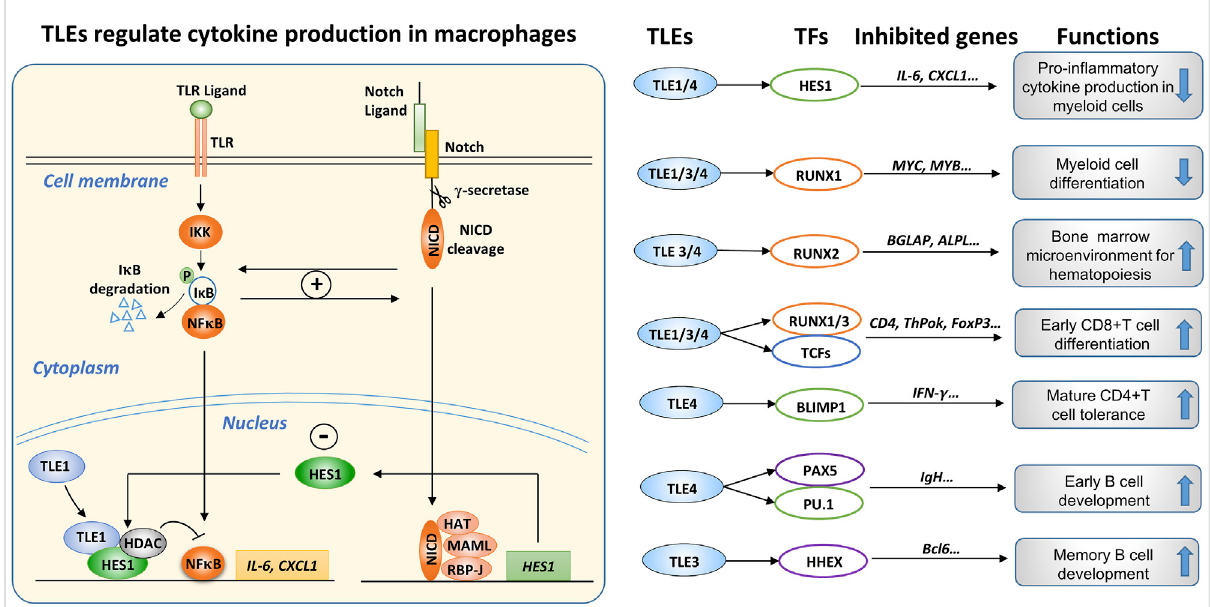
FIGURE 8 The roles ofTLEs in immune regulation. (Left): TLEs are involved inthe interconnection between theTLR and Notch pathwaysin macrophages. The engagement of TLR ligands activates IKK α / β kinase, inducing the phosphorylation and subsequent degradation of I κ B, which sequesters NF- κ B transcription factors (TFs) in the cytoplasm. Consequently, the released NF- κ B TFs, mainly p65 and p50, are translocated from the cytoplasm to the nucleus,wheretheystimulatetheexpressionofproin fl ammatorycytokines,suchasIL-6andCXCL1.Notchactivationinducestheexpressionof target genes, including HES1. The TLR and Notch pathways can regulate each other through a positive feedback loop; however, Notch activation induces the expression of HES1, which can form a transcriptional suppressive complex with TLE1/4 and HDACs, attenuating the expression of in fl ammatory cytokines. Therefore, TLE1/4, and possibly other TLE family members, are involved in the intricate interconnection between the TLR and Notch pathways in macrophages. (Right): Summary of the roles of TLEs in immune regulation, depicting TLE members, interacting TFs, suppressedtargetgenes,andeffects,includingcytokineproductioninmyeloidcells(Ramasamyetal.,2016),myeloidlineagedifferentiation(Simeoni andSomervaille,2021),hematopoiesis(Wheat etal.,2014),earlyTcell differentiation(Xingetal.,2018),Tcelltolerance (Bandyopadhyay etal.,2014), and early and memory B cell development (Milili et al., 2002; Laidlaw et al.,